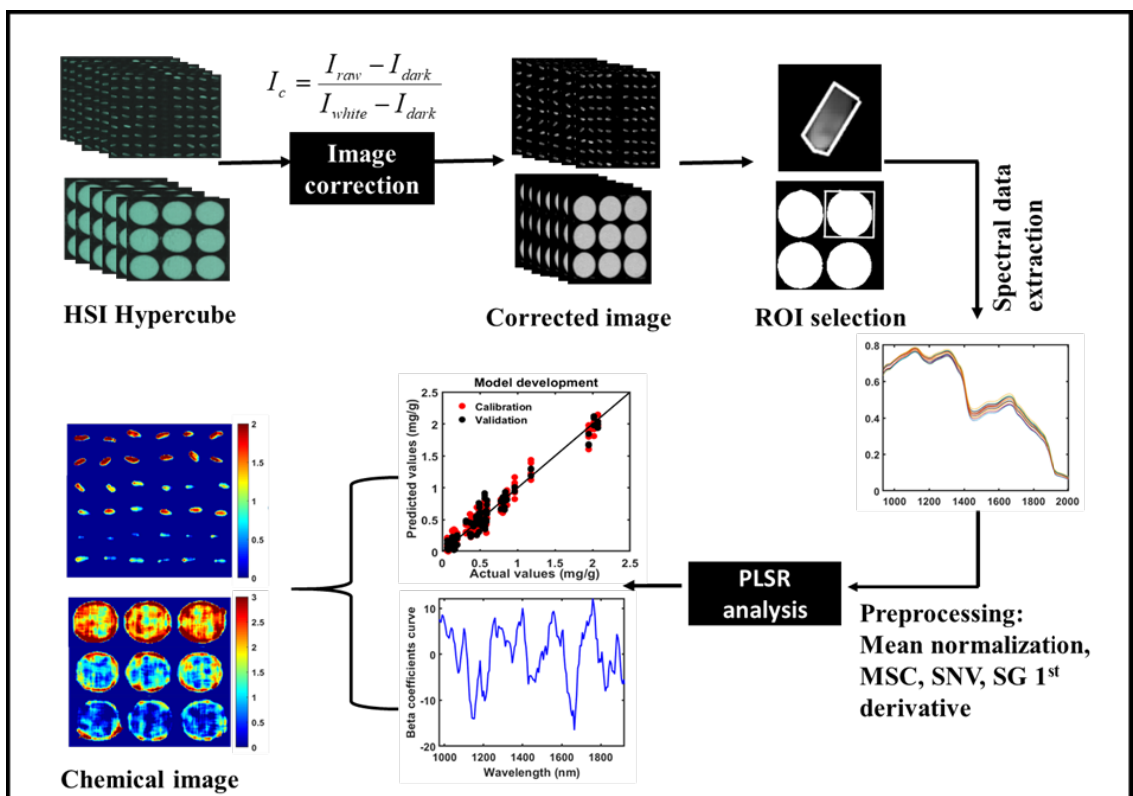
Figure 2. The strategy of hyperspectral data extraction and analysis.